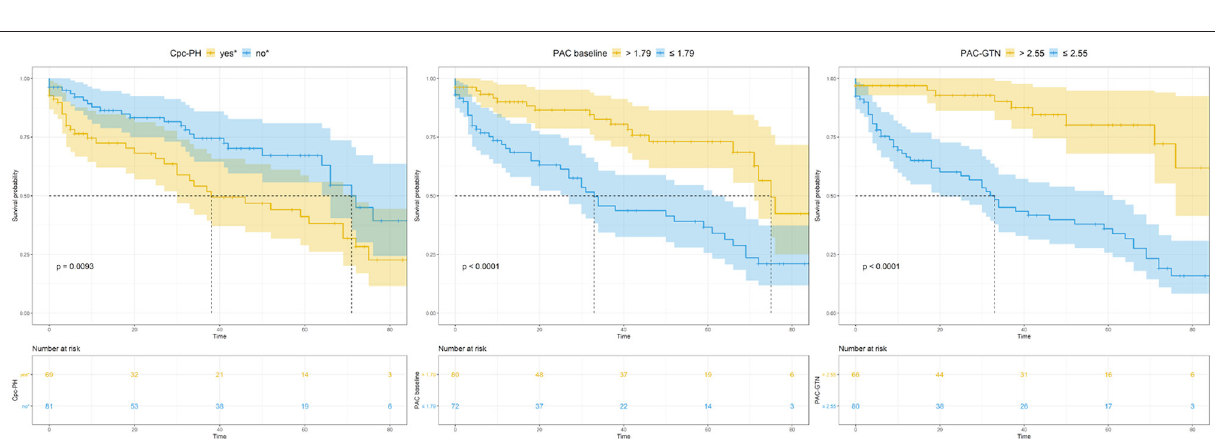
FIGURE 3 | AUC of ROC analysis for prediction of survival. Left panel: variables of the MAGGIC score; right panel: MAGGIC variables and PAC-GTN.